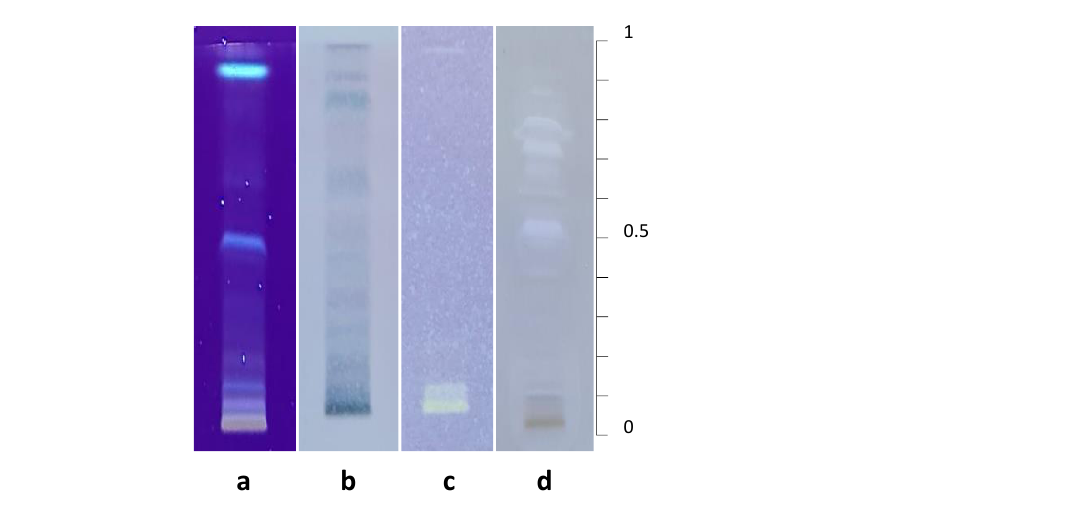
Figure A3. HPTLC plates of Fomitopsis pinicola EtOAc extract (50 µ g). Detection ( a ) under UV